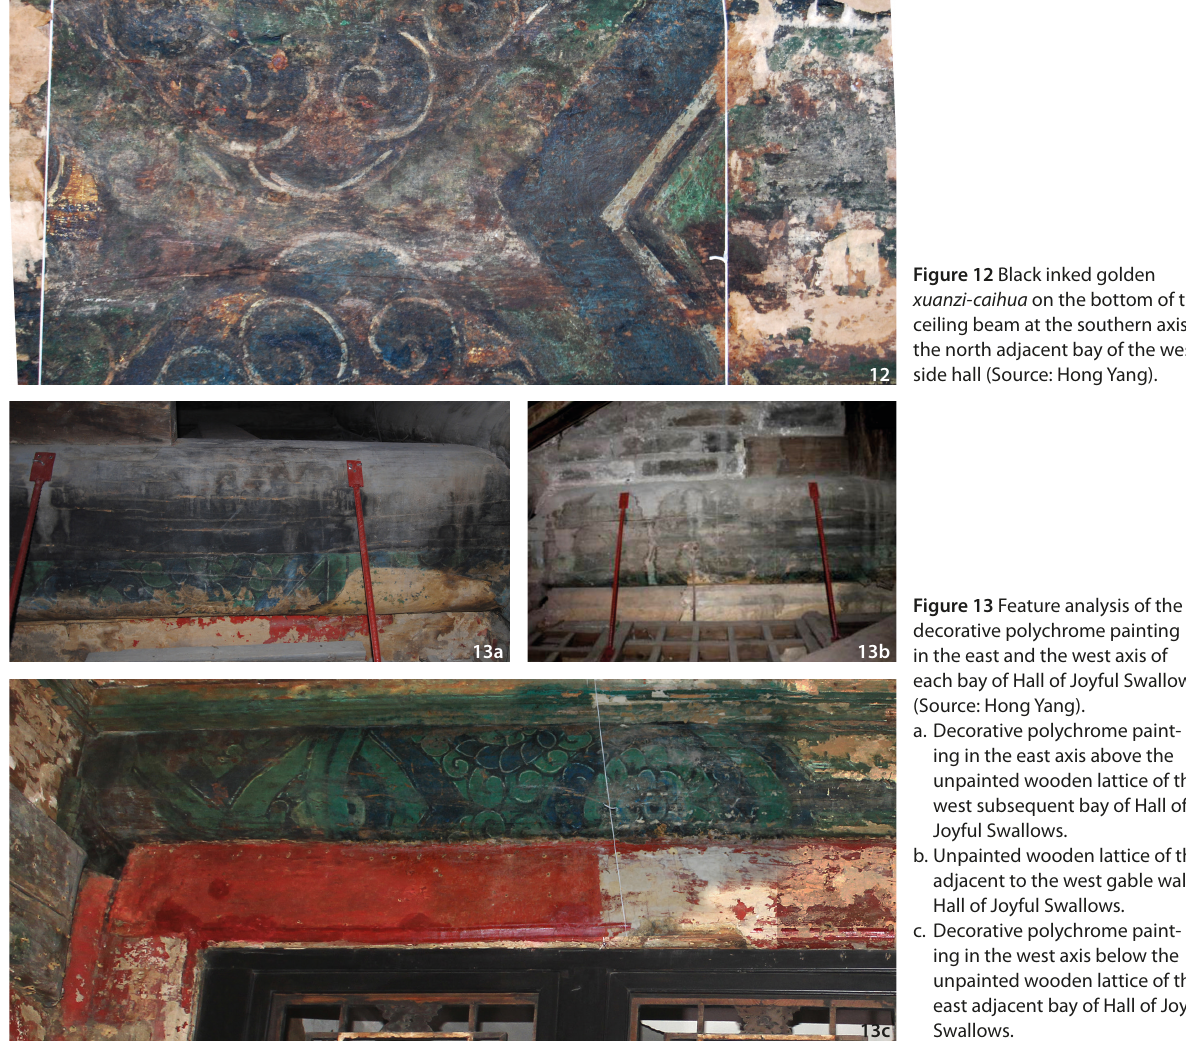
Figure 13 Feature analysis of the decorative polychrome painting in the east and the west axis of each bay of Hall of Joyful Swallows (Source: Hong Yang). a. Decorative polychrome paint- ing in the east axis above the unpainted wooden lattice of the west subsequent bay of Hall of Joyful